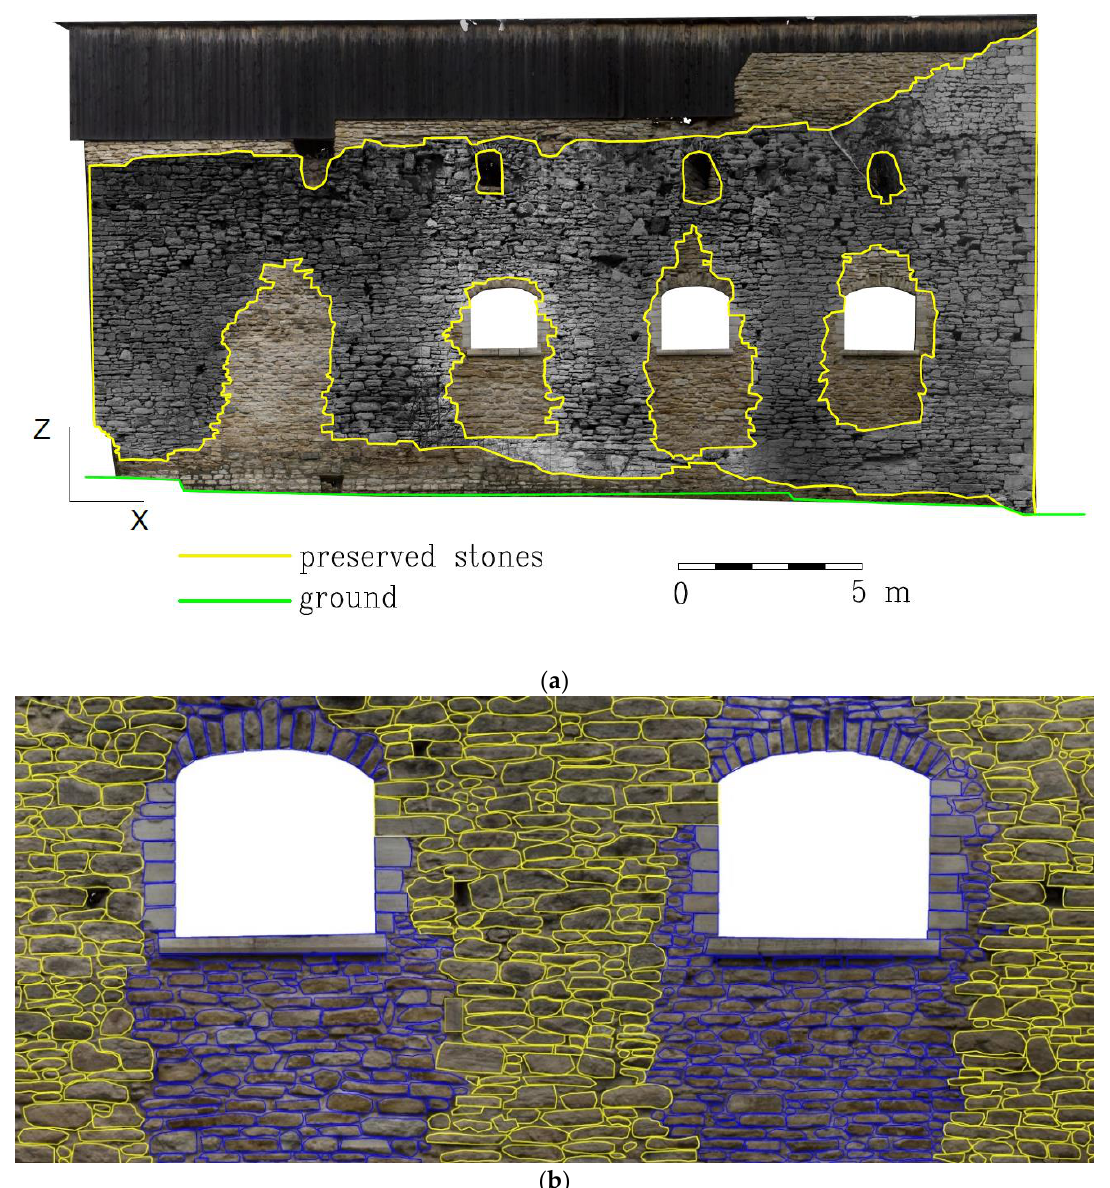
Figure 9. Comparison between states in 1991 and 2017 of the south wall of Padise Abbey: ( a ) an overlay of cropped orthophoto generated by re-processing (grey colors) and by new survey; ( b ) a drawing of stones. Yellow color indicates preserved stones, blue color indicates new stones after renovation.